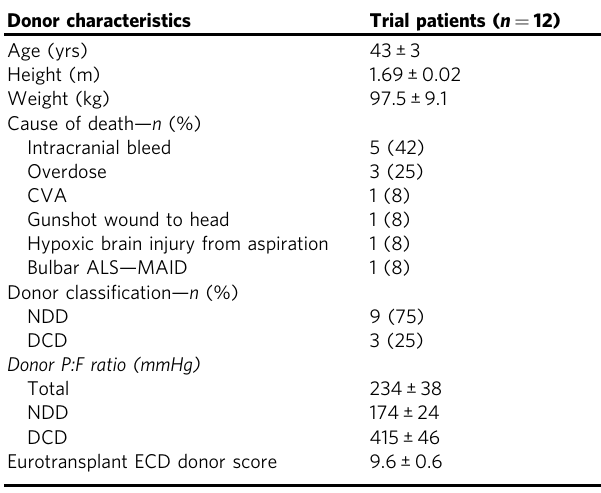
Table 1 Donor demographic